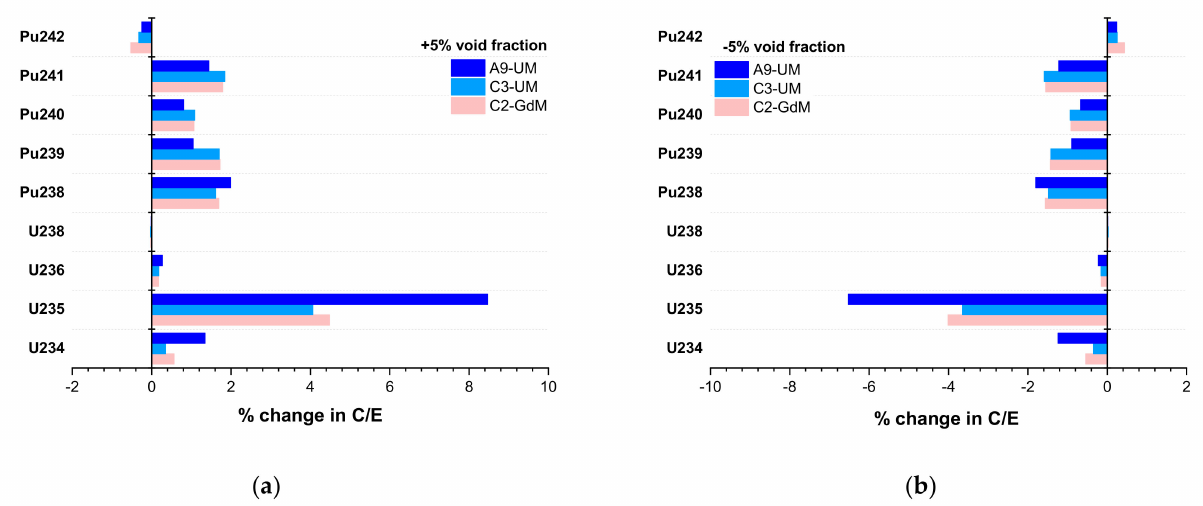
Figure 4. Change in U and Pu isotope C/E ratios due to changes in void fraction for samples from assembly 2F1ZN3: ( a ) 5% increase in void fraction; ( b ) 5% reduction in void fraction.